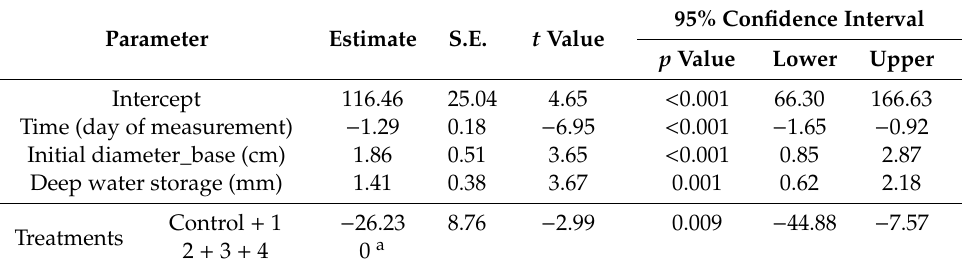
Table 3. Independent fixed e ff ects of the generalized linear mixed model (GLMM) with two